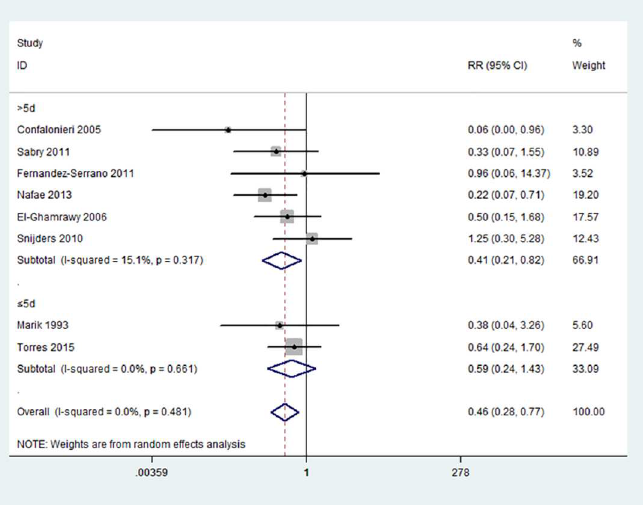
Fig 3. Subgroup analysis according to the duration of corticosteroids treatment in severeCAP.